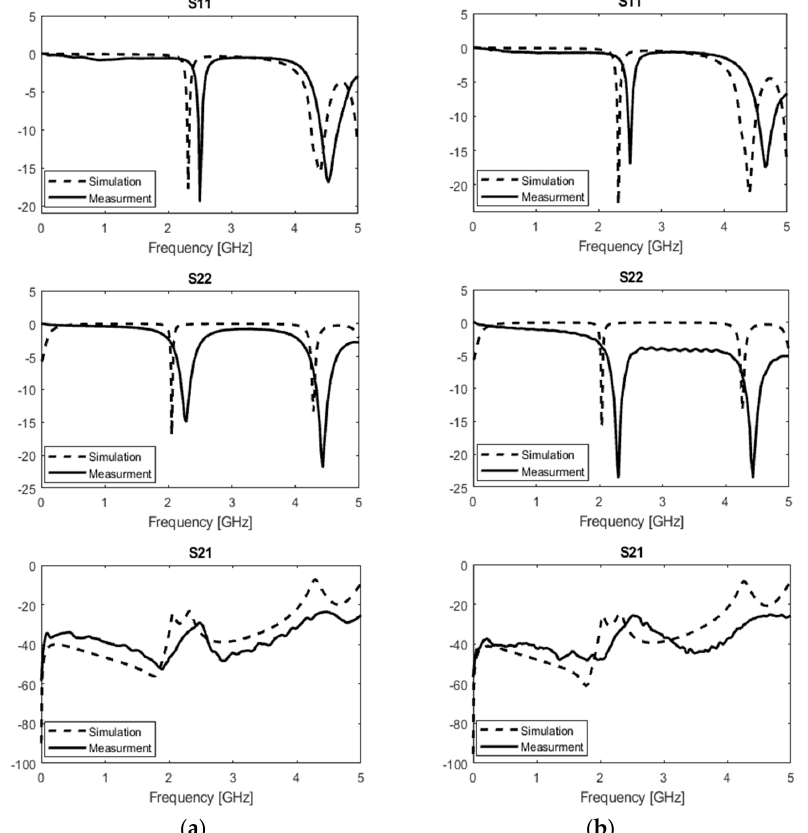
Figure 4. Scattering parameters S 11 , S 22 , and S 21 with 5 mm gap between the RX and TX, the RX is placed on ( a ) in free space, ( b ) on phantom. Table 3. Antenna specifications (M: Measurement, S: Simulation).